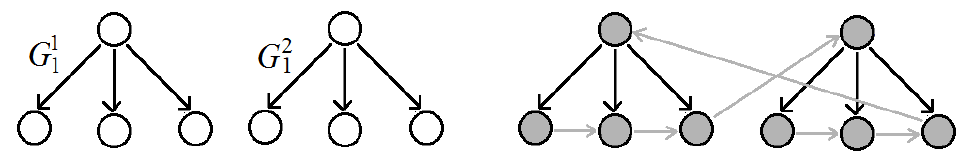
Figure 2. A strongly connected digraph constructed from the stars G 1